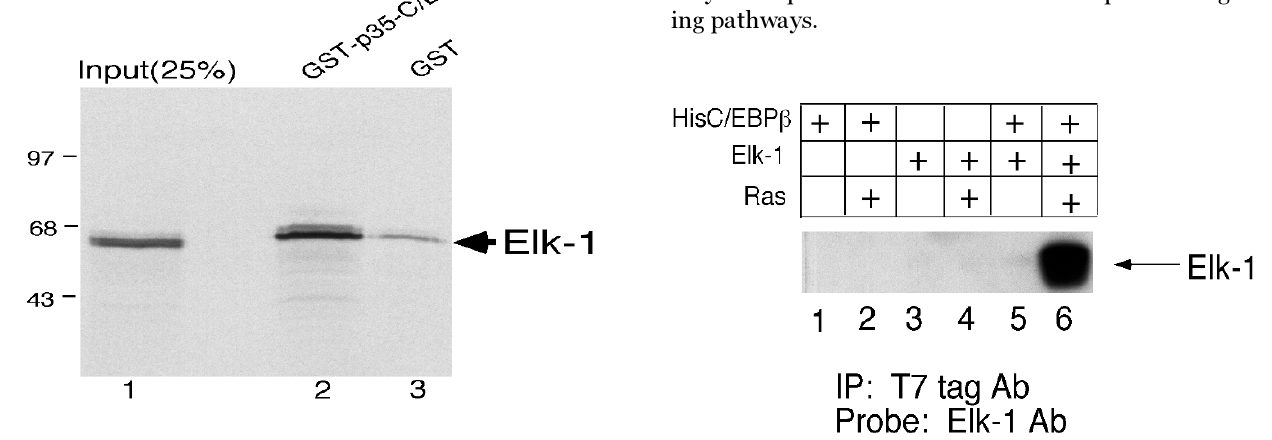
Elk-1 coimmunoprecipitates with p35-C/EBP β , but only in the presence of activated Ras. COS-7 cells were transfected with 10 µ g of pCDNA3.1/His-p35-C/EBP β (lanes 1, 2, 5, 6) and 10 µ g of pCMV-Elk-1 (lanes 3, 4, 5, 6) in the presence and absence of 2 µ g of pCMV-Ras.V12 as indicated. Cells were harvested 40 h post-transfection, and whole cell lysates were incubated with T7tag Ab-agarose beads, followed by immunoblotting of precipitated proteins with Elk-1